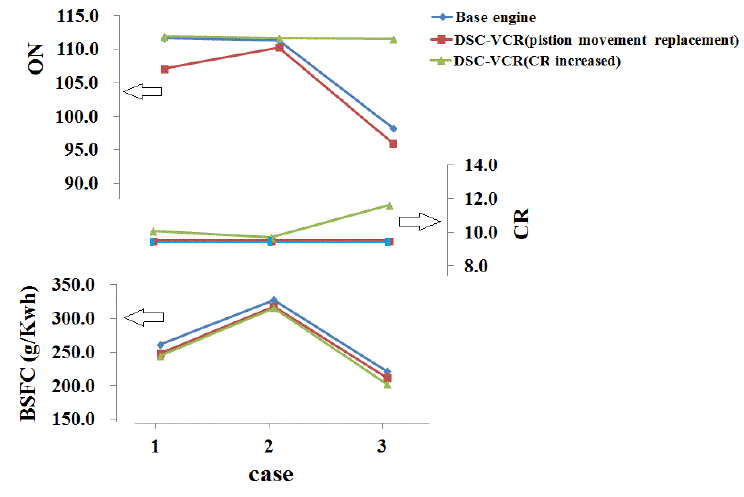
Figure 10. Variation of the octane number (ON), the CR, and the BSFC for different engines in step 1.